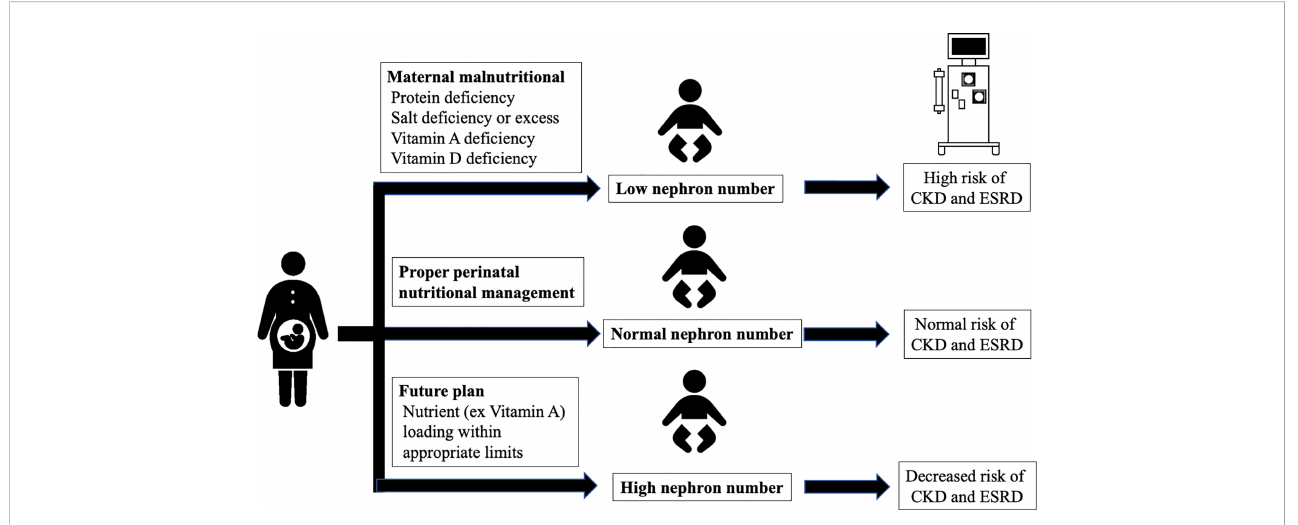
FIGURE 3 Interventions for glomerular number. CKD, chronic kidney disease; ESRD, end-stage renal